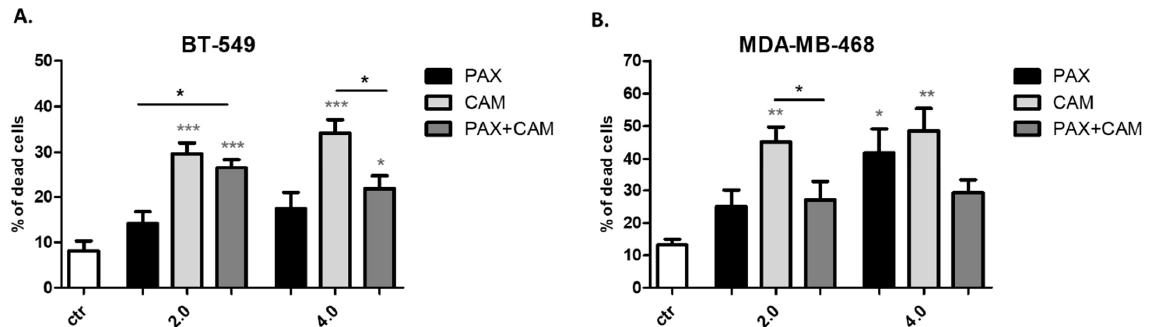
Figure 6. Effect of CAM and PAX alone or in combination on whole cell death induction in ( A ) BT